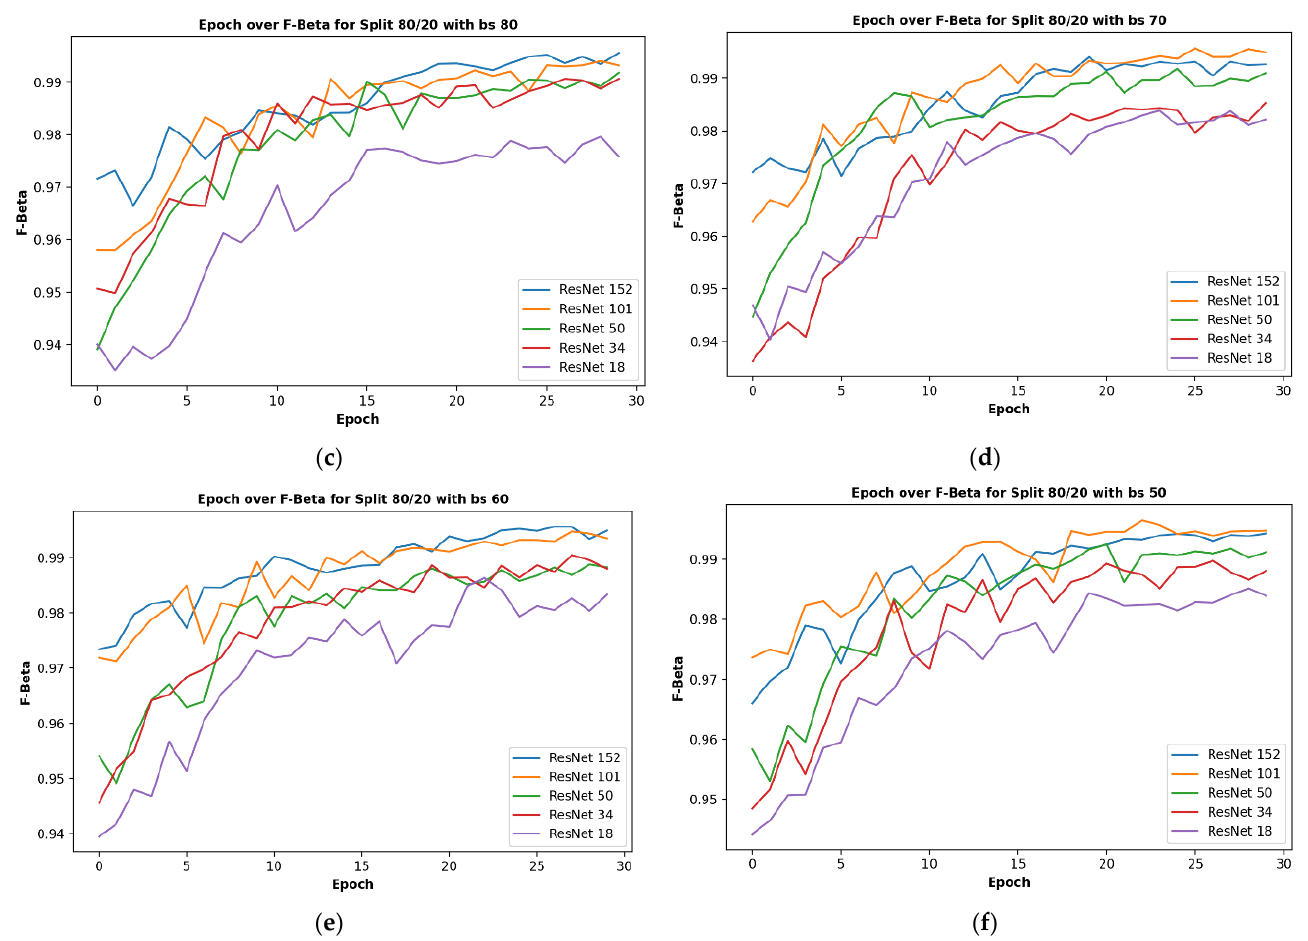
Figure 8. Showing the results on different train/test split ratios on various models used in our research: ( a ) showing epoch over F1 score for ResNet-18; ( b ) showing epoch over F1 score for ResNet- 34; ( c ) showing epoch over F1 score for ResNet-50; ( d ) showing epoch over F1 score for ResNet-101; ( e ) showing epoch over F1 score for ResNet-152; ( f ) showing epoch over F1 score for ResNet-152 on a batch size of 80, this is where the best F1score of our research is located.